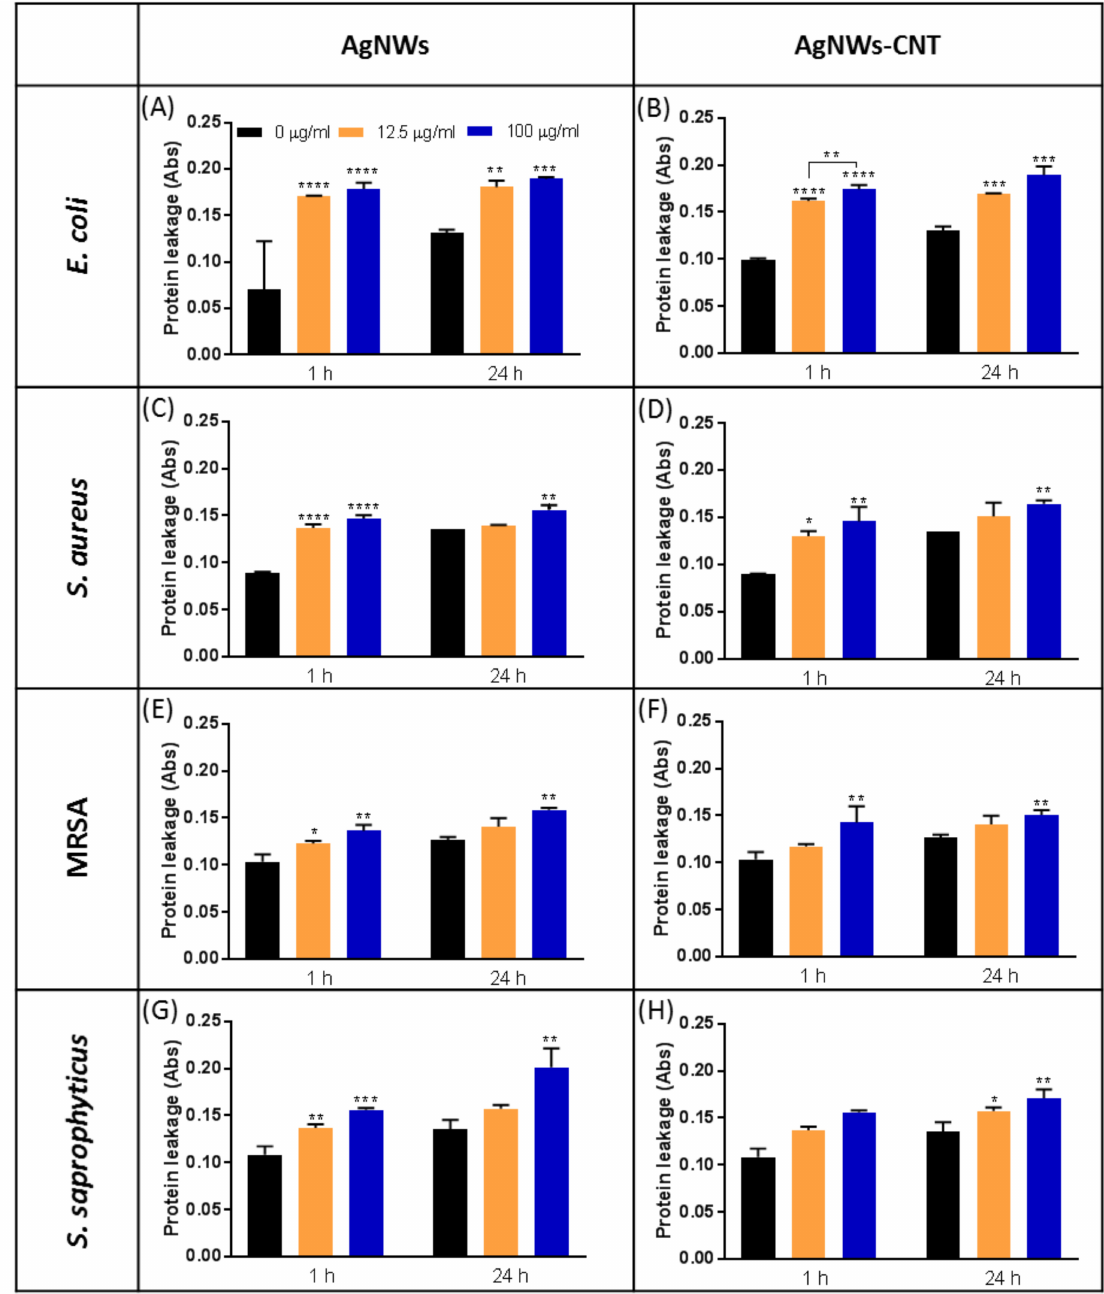
Figure 4. Absorbance relative to protein release after 1 and 24 h of treatment for E. coli ( A , B ), S. aureus ( C , D ), MRSA ( E , F ) and S. saprophyticus ( G , H ) treated with 12.5 or 100 µ g / mL of AgNWs or AgNWs-CNT. Data are presented as the mean ± SD ( n = 4). The one-way ANOVA performed on all the samples showed significantly di ff erent releases for both AgNWs and AgNWs-CNT ( p < 0.05). Results of the post-hoc Tukey multicomparison test are shown in the graphs (* indicates p < 0.05, ** indicates p < 0.01, *** indicates p < 0.001 and **** indicates p <